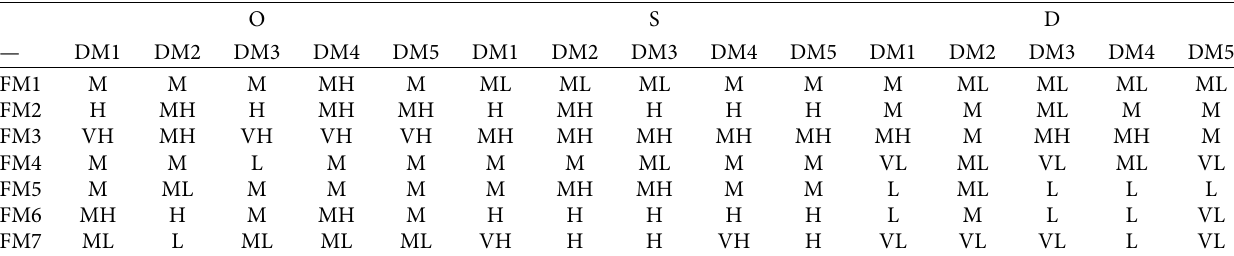
Table 3: The original data